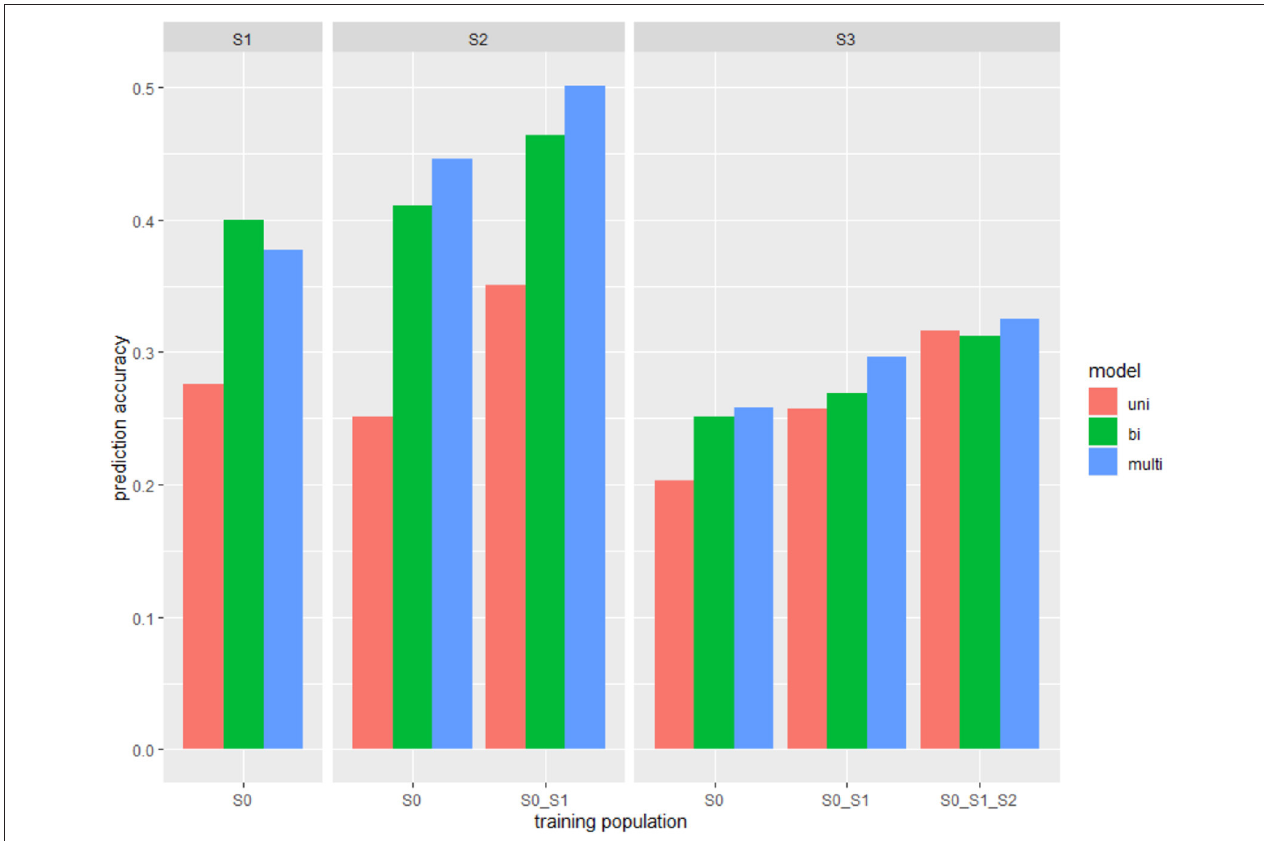
FIGURE 3 | The PA for forward prediction scenarios where one or multiple breeding stages were used as the training set to predict the grain yield in the next breeding stage with different models (uni, univariate; bi, bivariate; multi,